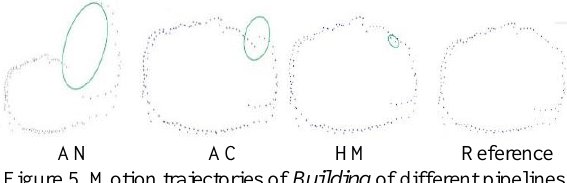
Figure 5. Motion trajectories of Building of different pipelines.